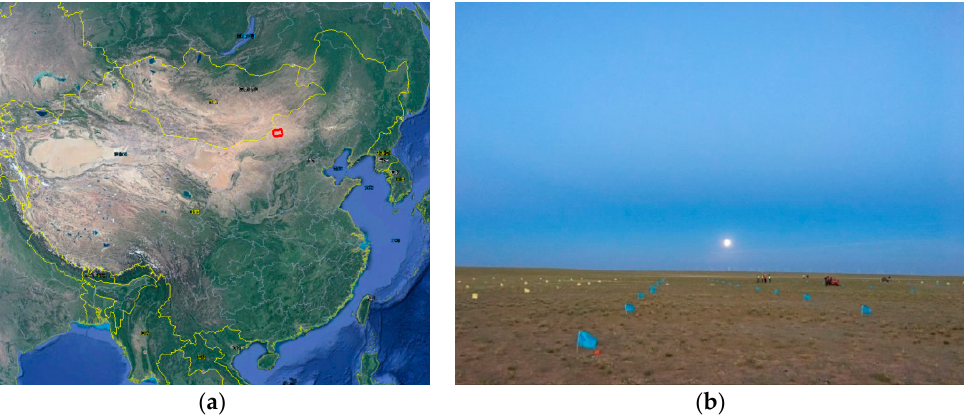
Figure 10. Laser altimeter calibration site: ( a ) calibration site location; and ( b ) detector arrays.